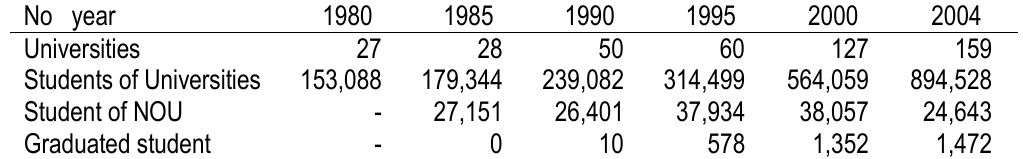
Table1. A Comparison on the Number of University and Student in Taiwan (Unit: person, %) No year